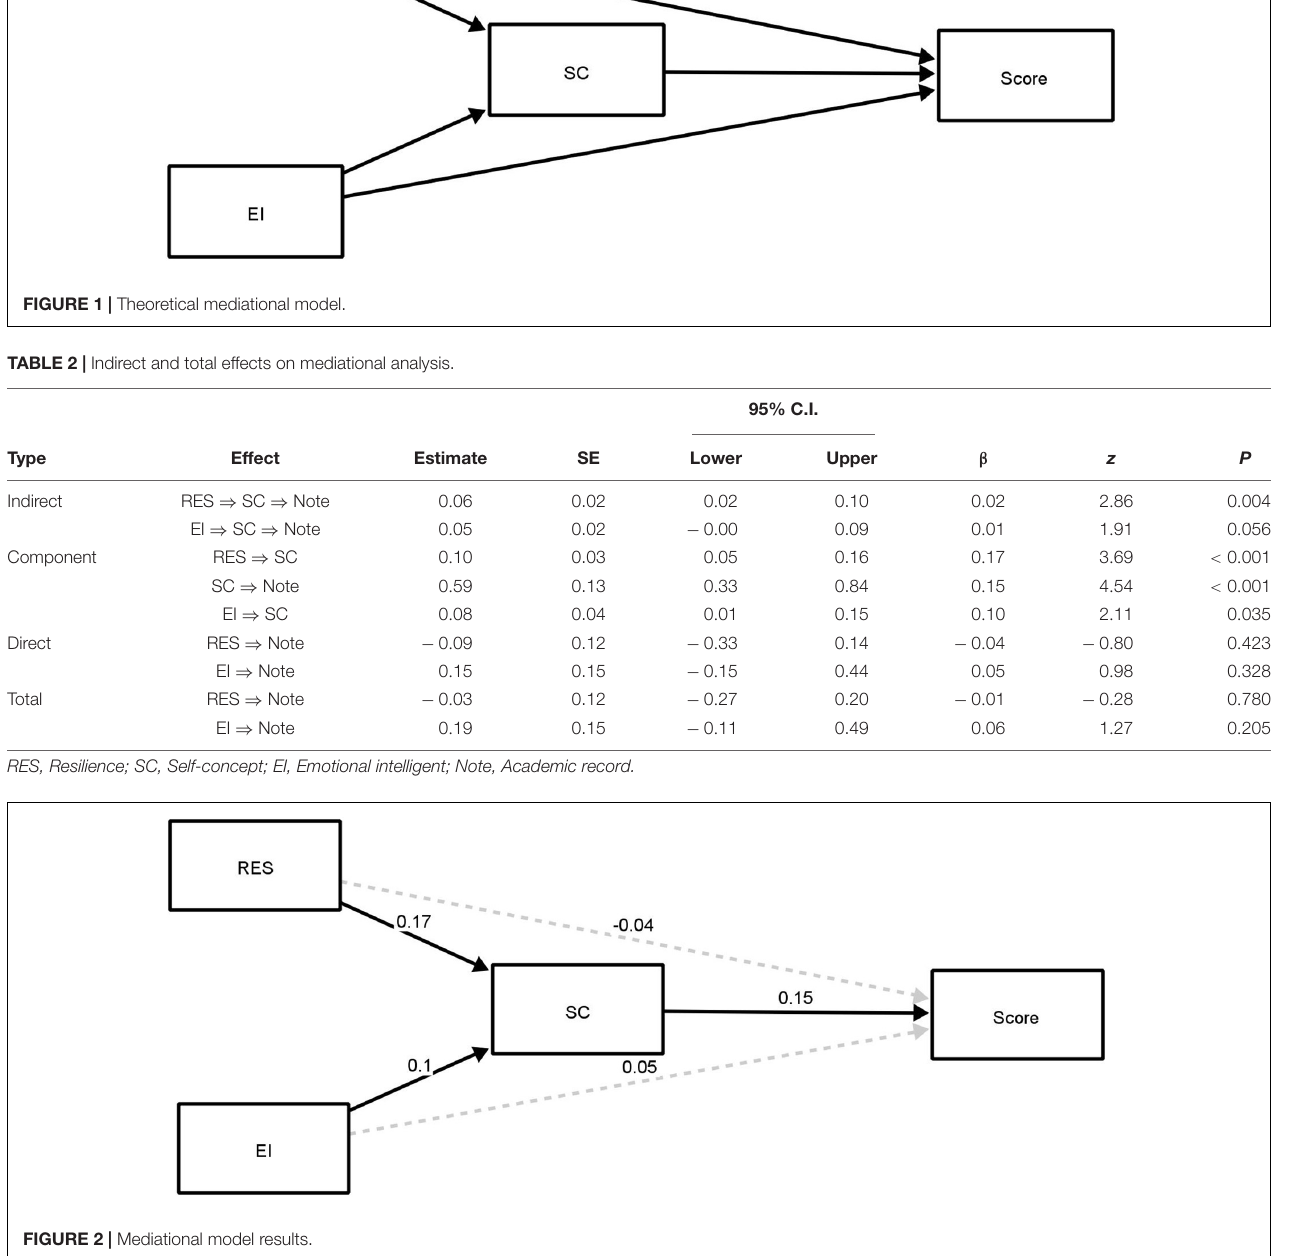
FIGURE 2 | Mediational model